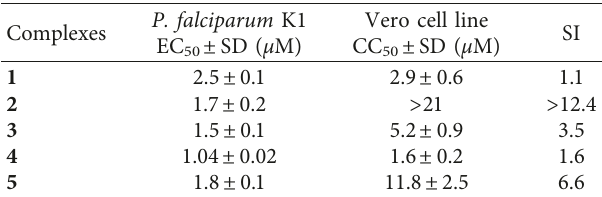
Table 2: Antiplasmodial and cytotoxicity activities of silver(I) complexes.